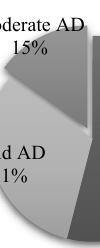
8 of 19 Figure 2. Distribution of the population described in the database by sex.